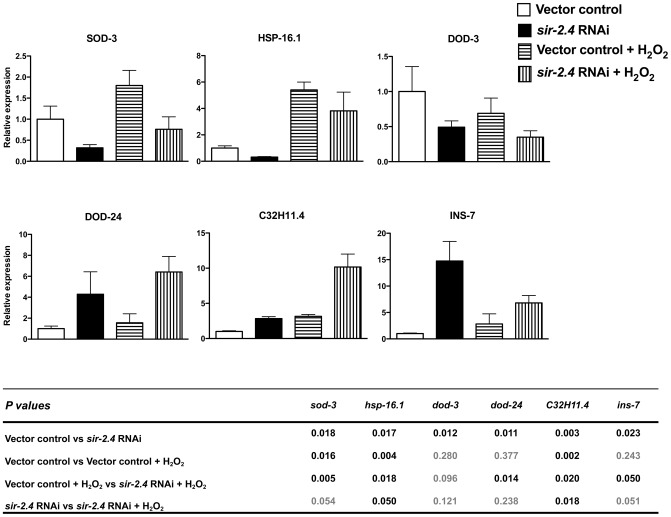
SIR-2.4 is required for optimal DAF-16–dependent gene expression.Wild-type N2 animals fed on either vector control or sir-2.4 RNAi bacteria from the time of hatching were exposed to 10 mM H2O2 for 80 min. Relative mRNA levels of SOD-3, HSP-16.1, DOD-3, DOD-24, C32H11.4, and INS-7 were measured by quantitative RT-PCR and the means of three different sample sets are shown. Relative mRNA levels were normalized against ACT-1 (beta-actin). Error bars: ± STD. Statistical significance as determined by two-tailed t-test is shown in the table below; significant differences are represented in black font.